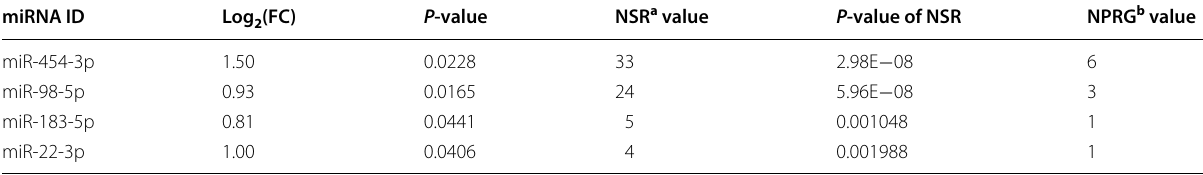
a Number of single-line regulation in the miRNA-mRNA network b Number of platinum resistance-associated genes (NPRG) among miRNA targets